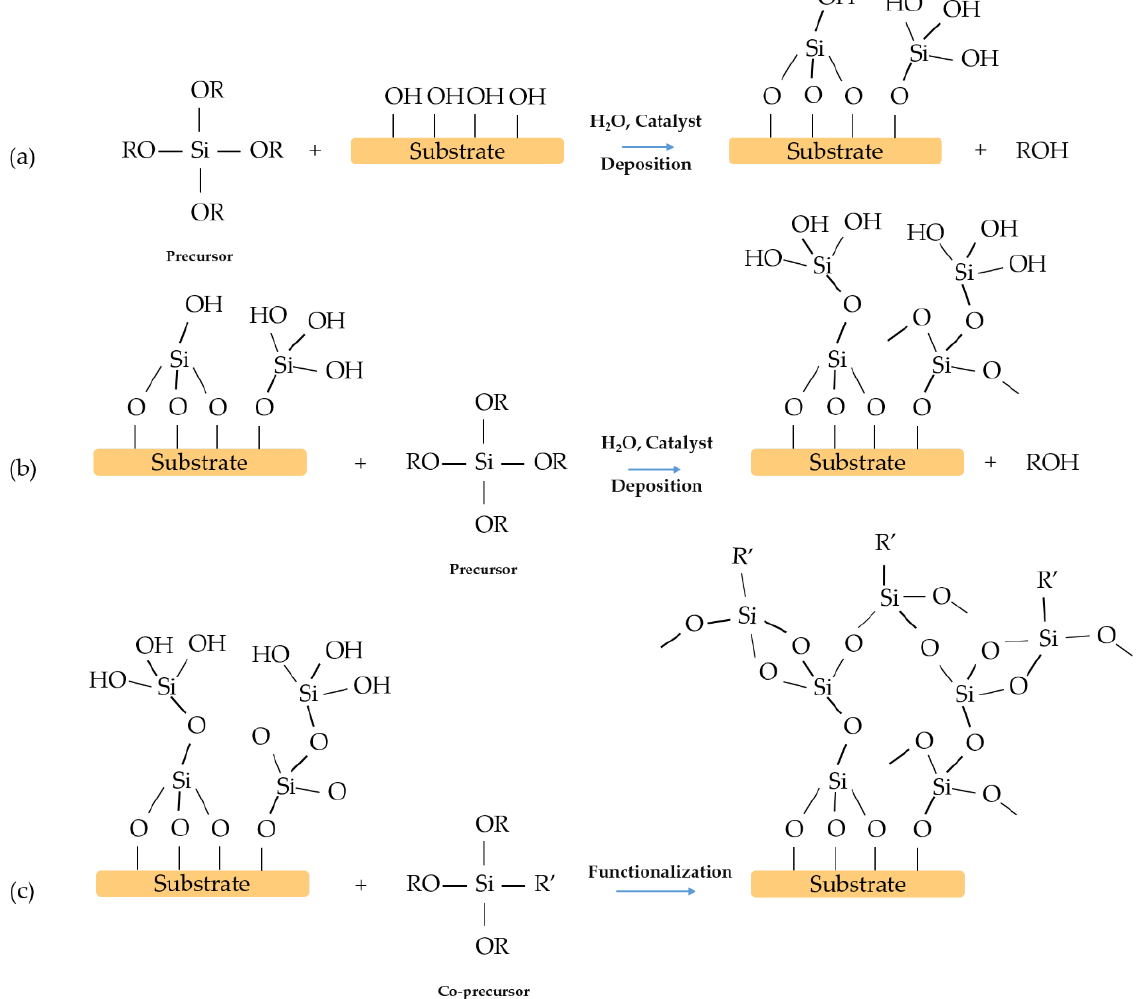
Figure 12. Example scheme of a multilayer synthesis: ( a ) deposition of the first layer, ( b ) deposition of the second layer, ( c ) functionalisation of the film.